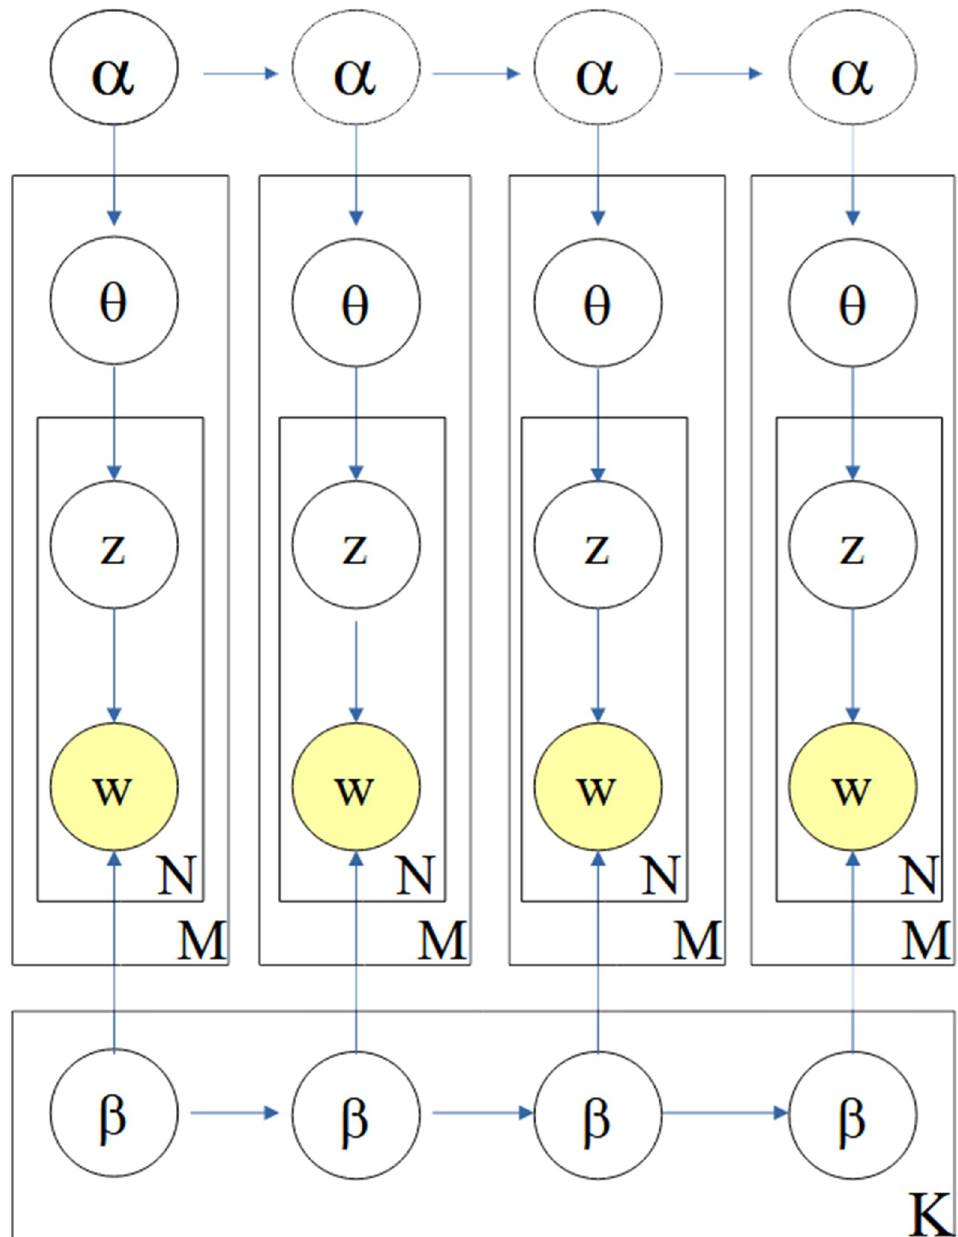
Fig 1. Dynamic topic model (for four time slices). A set of topics in the dataset are evolved from the set of the previous slice over time series. The model for each time slice corresponds to the original LDA process. Additionally, each topic’s parameters and evolve over time. (Blei and Lafferty, 2006